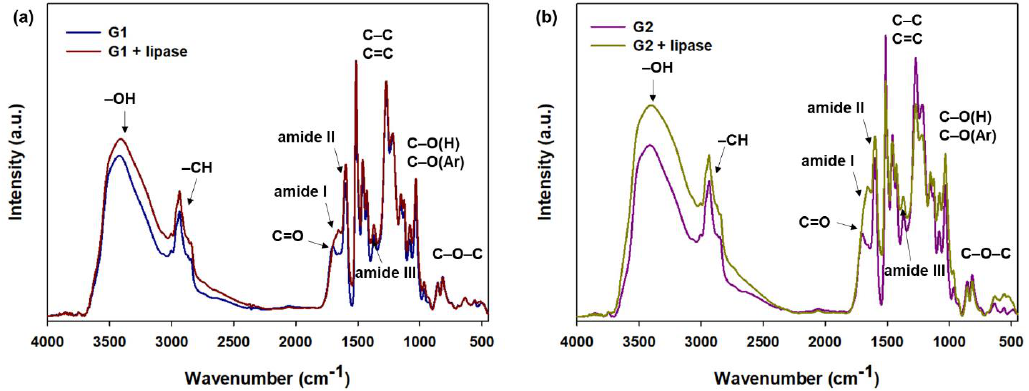
Figure 3. FTIR spectra of materials G1 ( a ) and G2 ( b ) before and after lipase